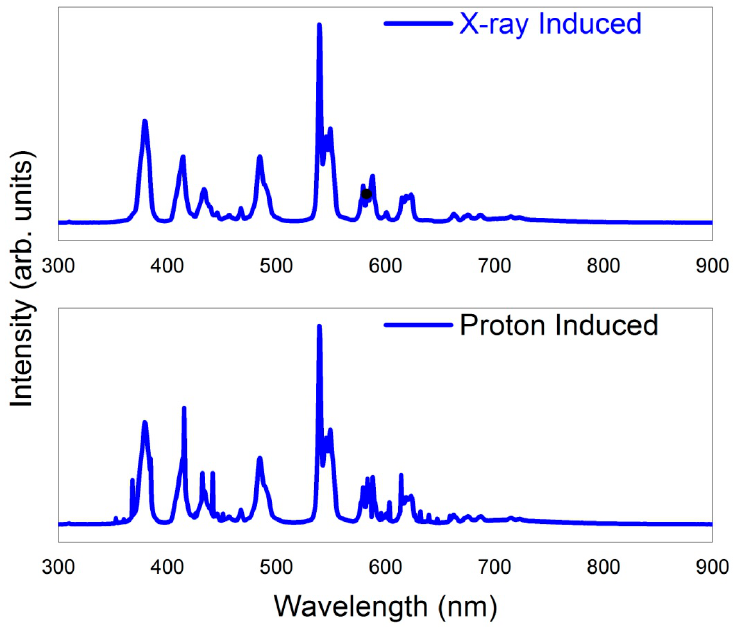
Figure 8. X-ray and proton-induced emission spectra of LuGd 2 Ga 2 Al 3 O 12 :Tb 3+ .